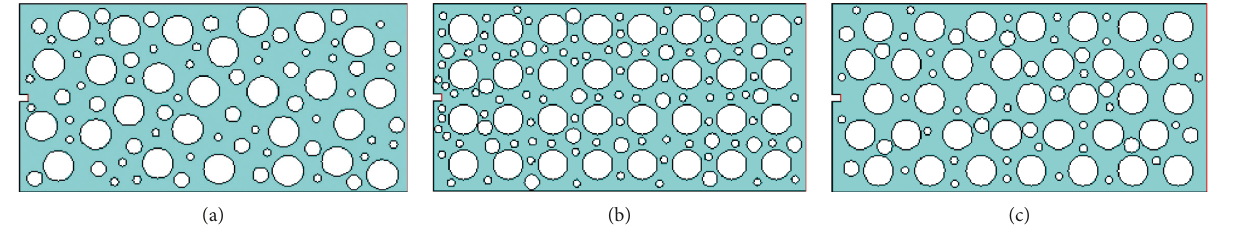
Figure 1: Numerical calculation model. (a) Structure 1. (b) Structure 2. (c) Structure